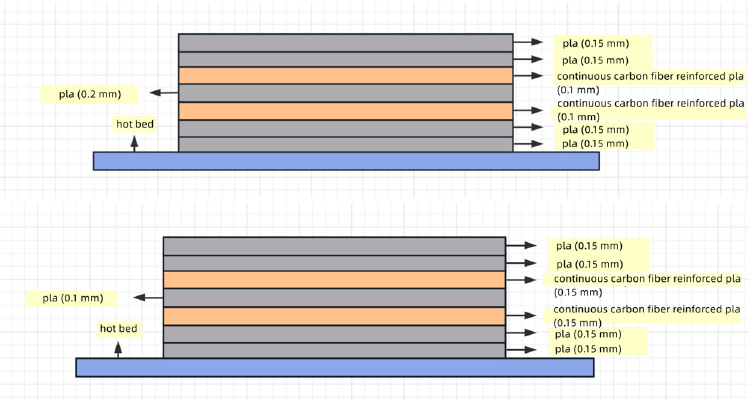
Figure 4. Reinforced fiber layer placement diagram with layer thickness of 0.1 mm, 0.15 mm.